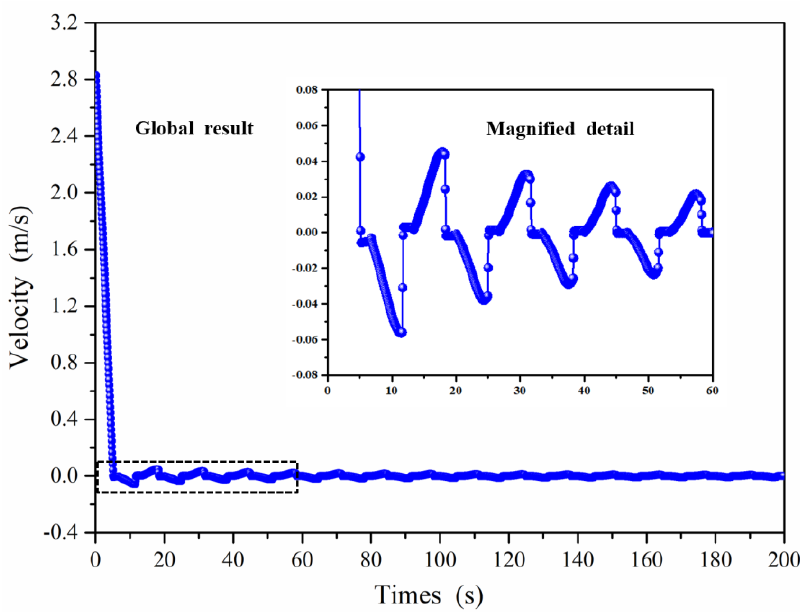
Figure 7. Difference of natural frequency of tubing under two model analysis methods.